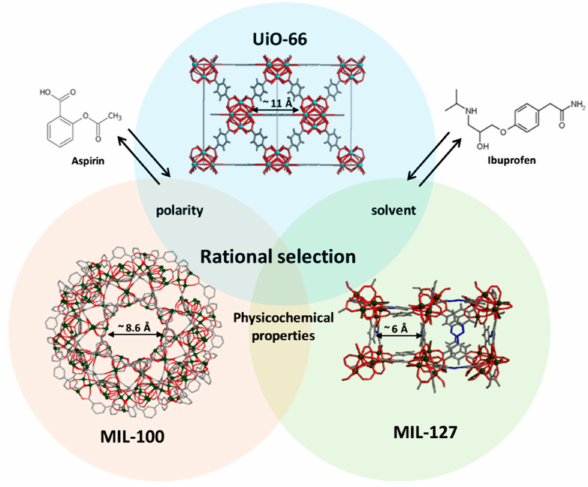
Figure 2. Structures of acetylsalicylic acid (aspirin) (left) and isobutylphenylpropanoic acid (ibuprofen) (right) with structural representation of UiO-66, MIL-100 and MIL-127. Zirconium polyhedra are cyan, iron polyhedra are green, nitrogen is blue, oxygen is red, and carbon is grey. Hydrogen atoms have been removed for clarity [33] Reprinted from S. Rojas, I. Colinet, D. Cunha, T. Hidalgo,